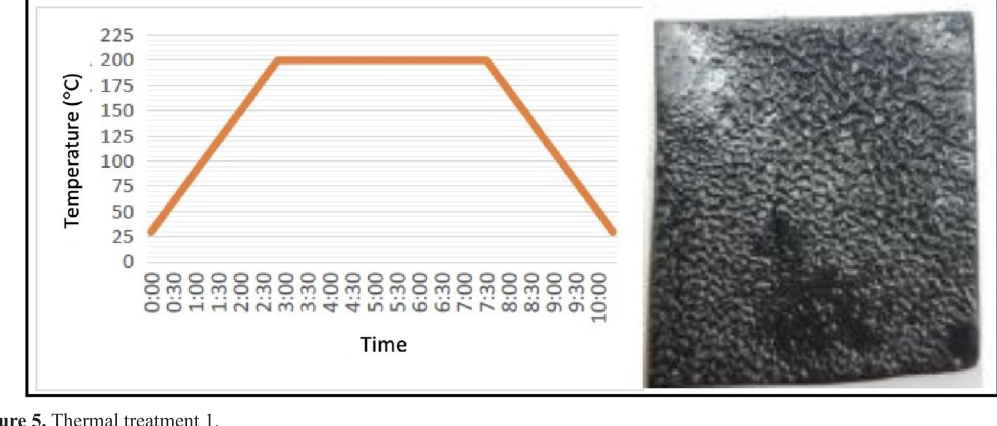
Figure 5. Thermal treatment 1.